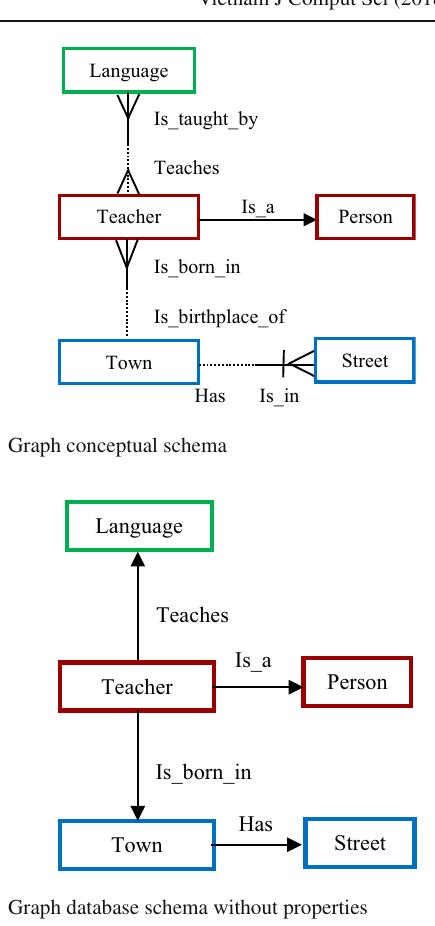
Fig. 5 Graph database schema without